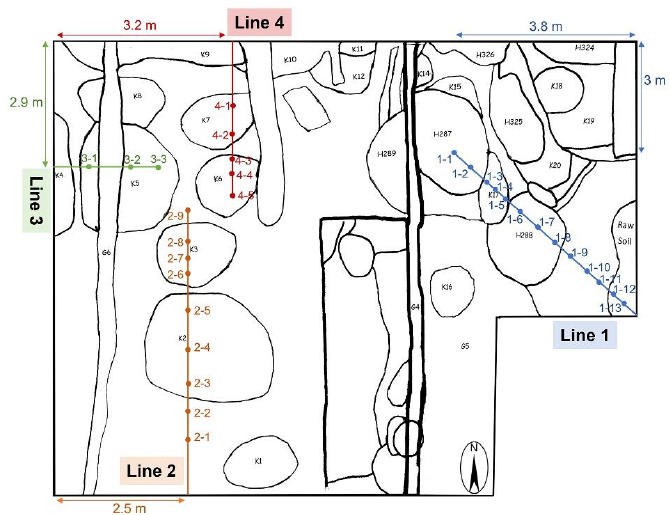
Figure 2. Samples collected from the suspected rice paddy field area. Line 1 is from the center of H287 to the raw soil area; Line 2, Line 3, and Line 4 are from the south, the west, and the north wall to the center, respectively.